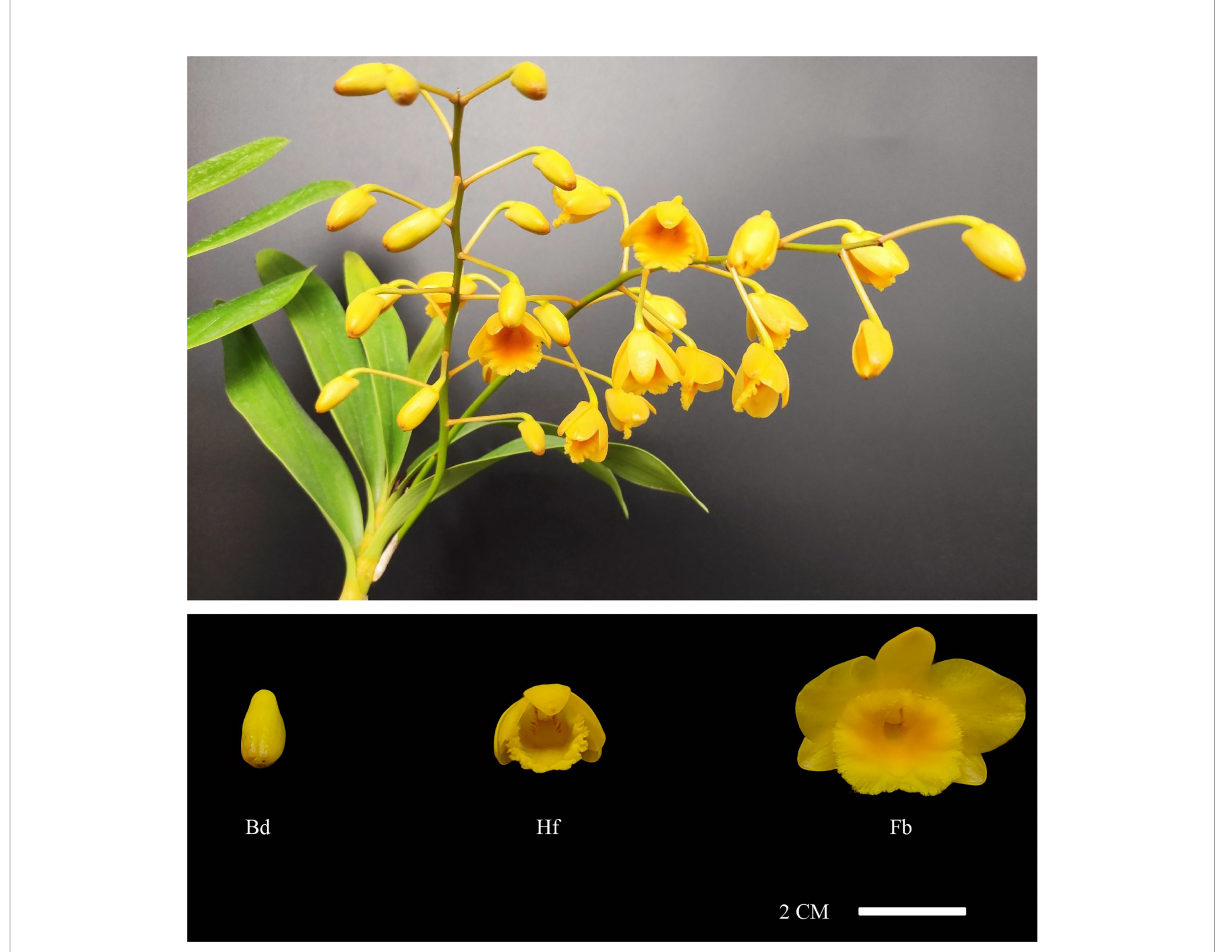
FIGURE 1 Floral organs phenotypes of D. chrysotoxum at different fl owering stages. Bd, budding stage; Hf, half-open stage; Fb, full-bloom